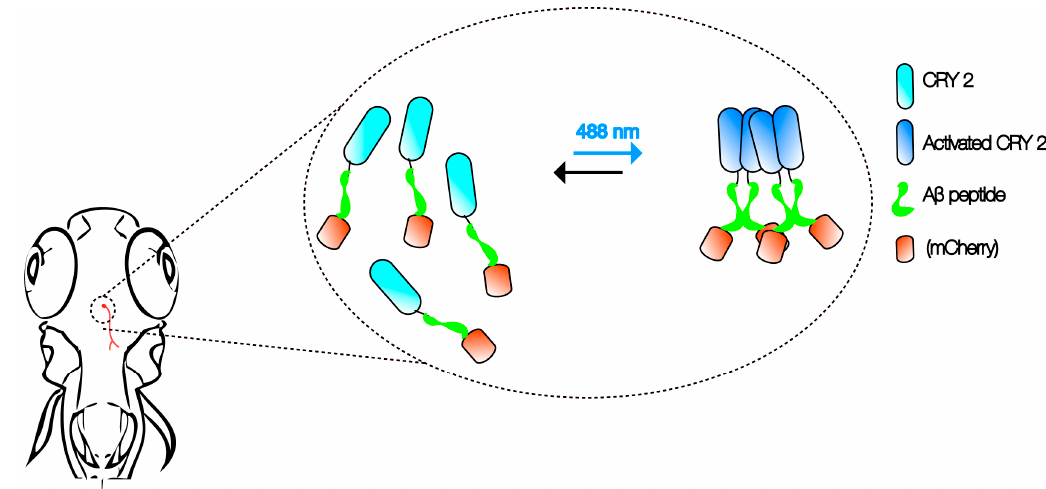
Figure 1. A β CRY2 optogenetic system. The schematic shows an example of in vivo, light-dependent, oligomerization switch for the formation or dissolution of A β aggregates in region of interest (neurons) in a transgenic zebrafish.